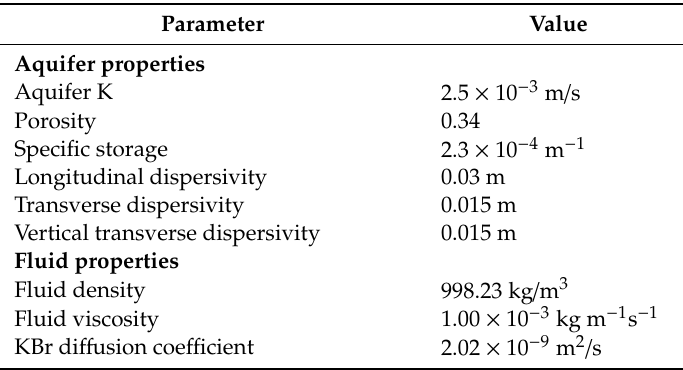
Figure 2. ( A ) Model domain and ( B ) boundary condition for the numerical simulation. Table 3. Input parameters for the numerical simulation.